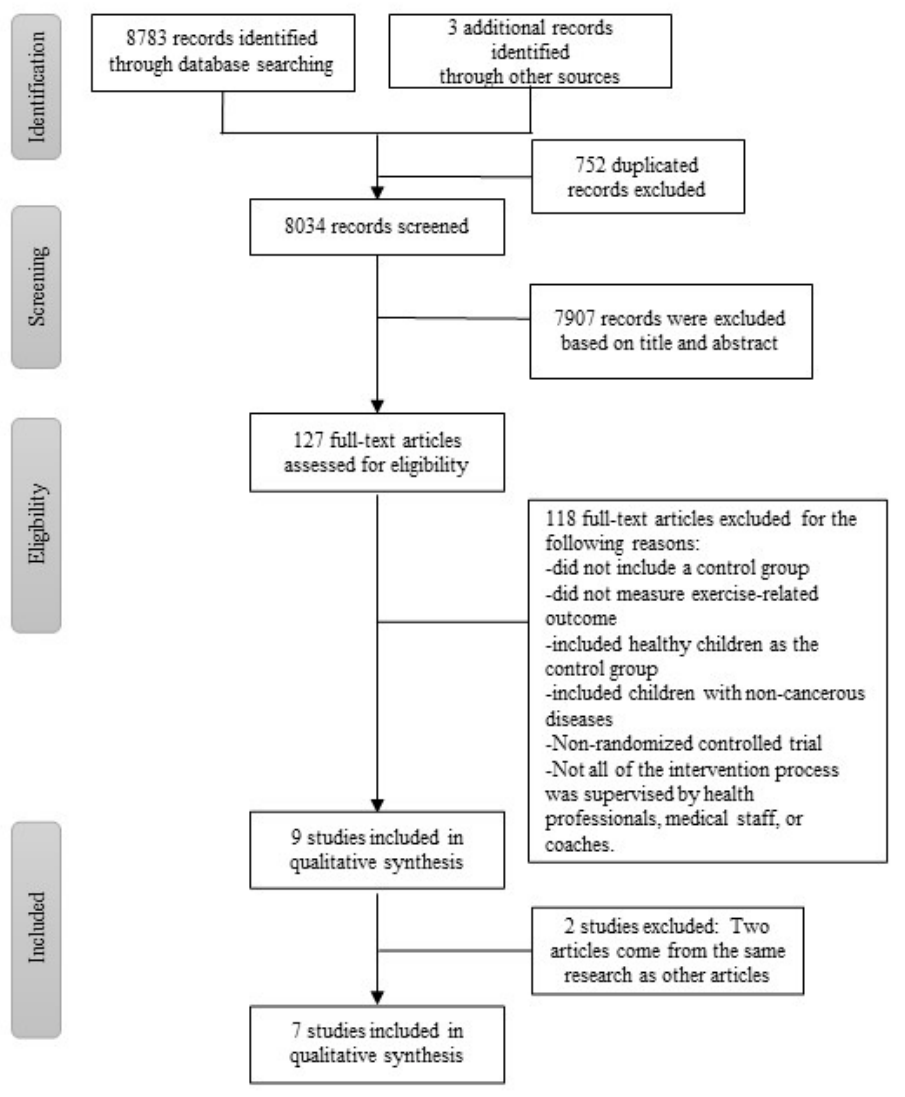
Figure 1. PRISMA flow chart illustrating the detail of the search strategy.